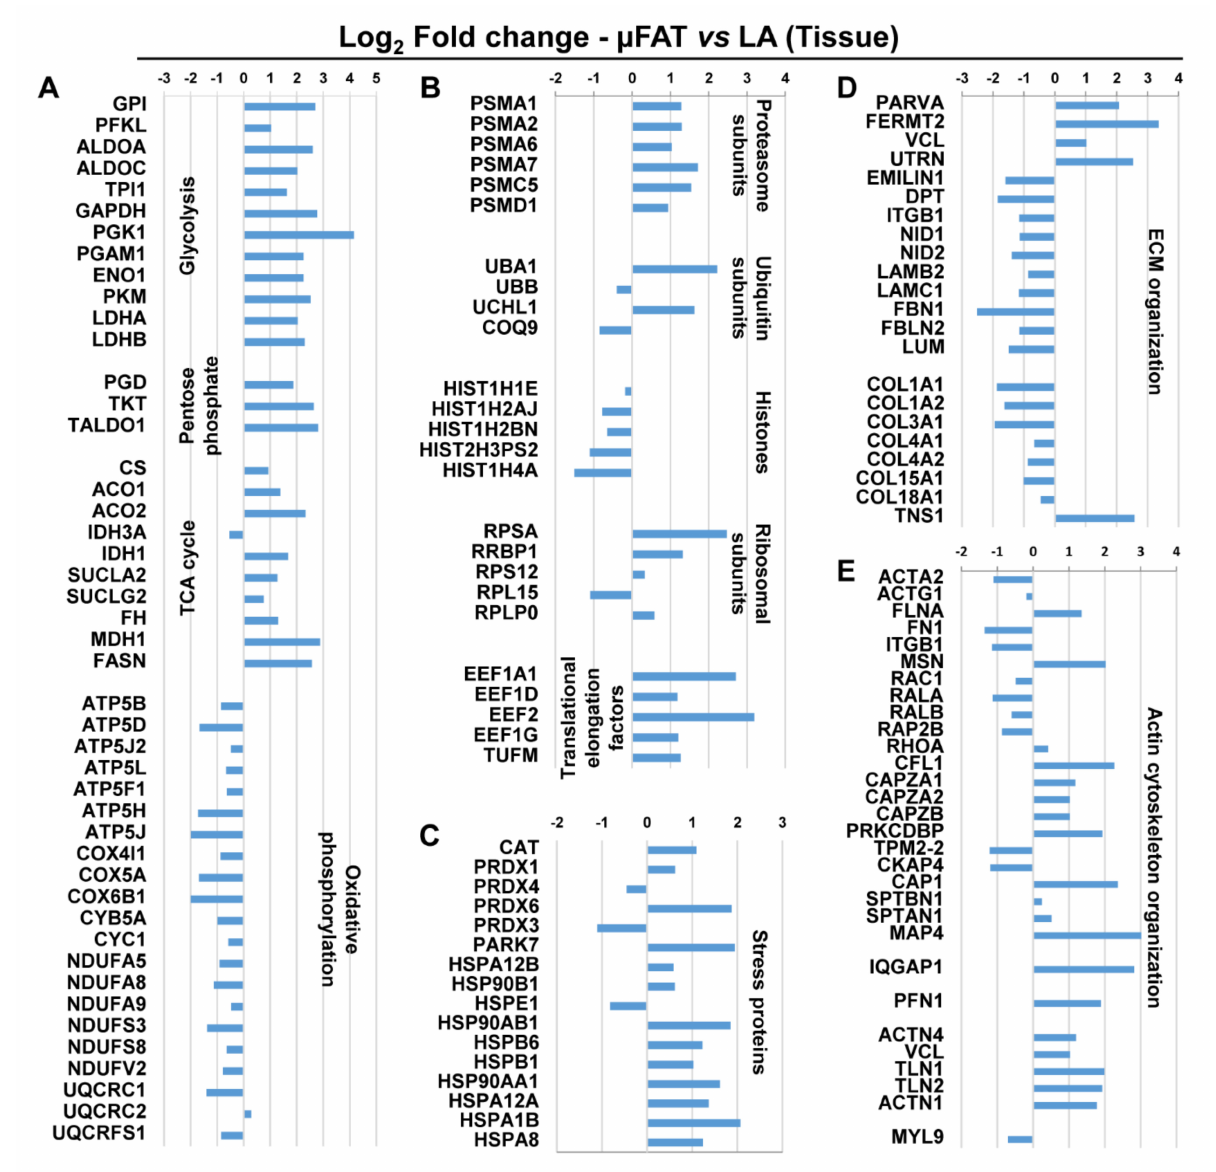
Figure 4. Modulated proteins in µ FAT vs. LA tissues according to statistically relevant dysregulated pathways. All displayed proteins are significantly modulated ( p -value < 0.05). ( A ) Metabolic proteins. ( B ) Structural proteins involved protein degradation and synthesis. ( C ) Stress-related proteins. ( D ) ECM organization including collagens. ( E ) Actin